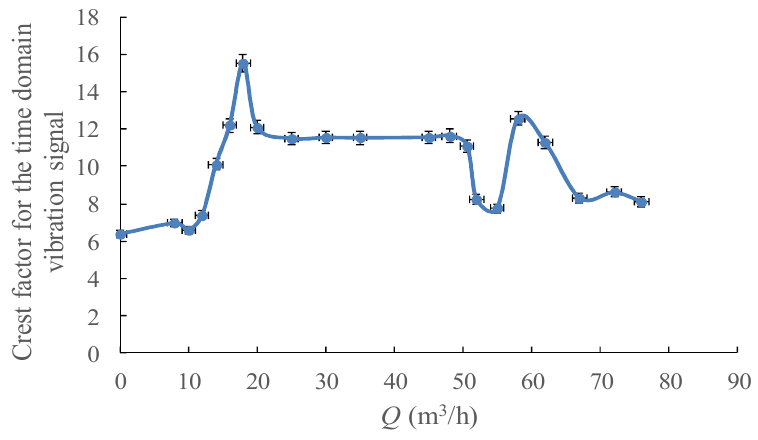
Figure 10. Crest factor for the time domain vibration signal under different flowrates.